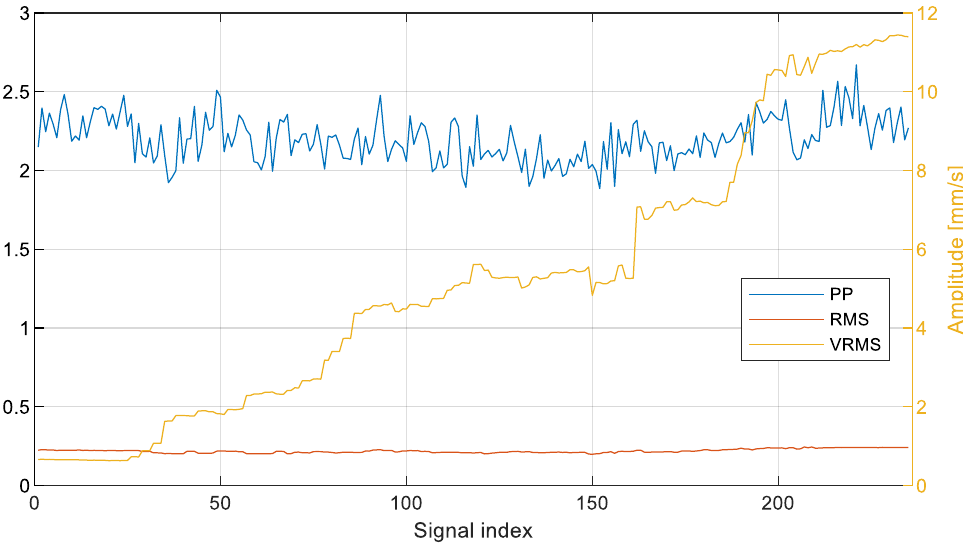
Figure 9. Broadband and narrowband HIs in detection of imbalance state. Signal index represents subsequent instances of vibration signals.